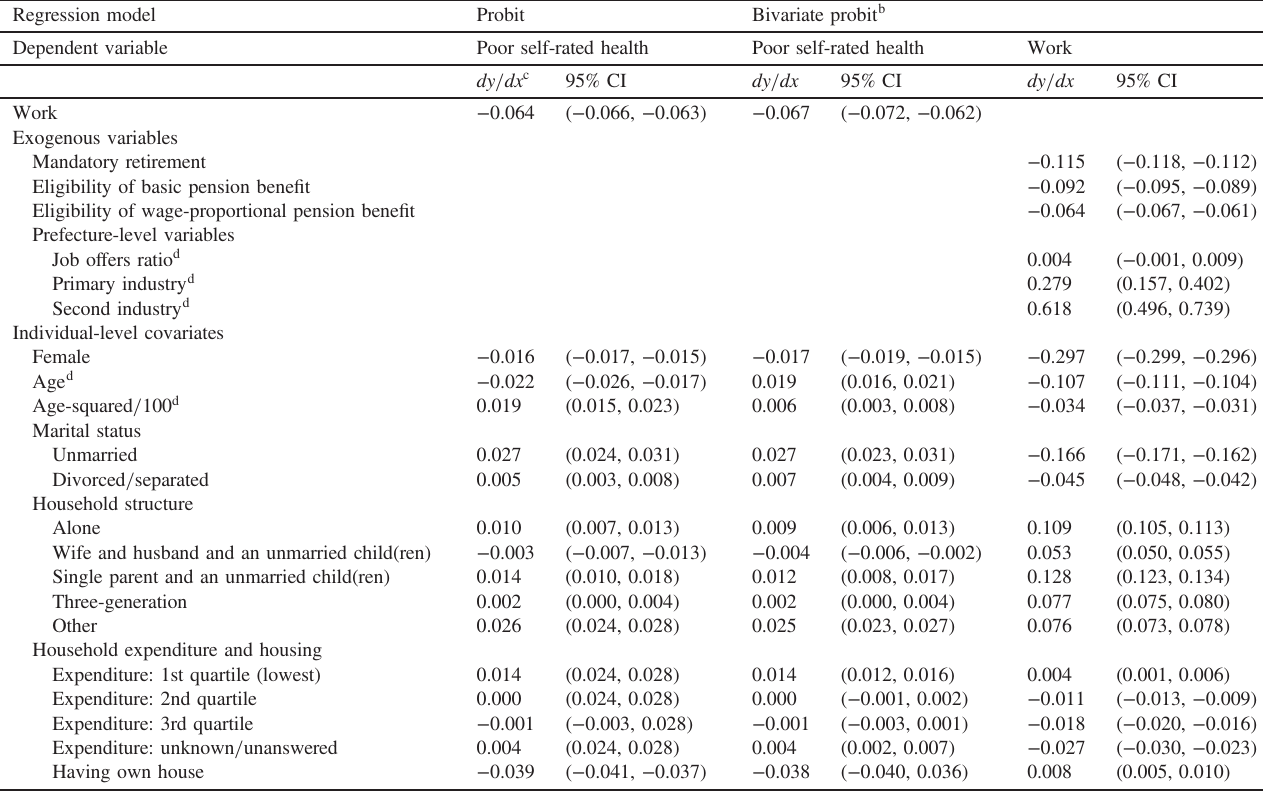
Table 3. Estimation results of the probit and recursive bivariate probit models for predicting poor self-rated health a ( N = 1,352,788)